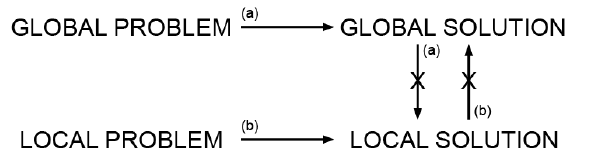
Figure 2. Arrows indicate the typical paths used to reach solutions (a) and (b). Crosses indicate where the difficulties can be found. For example: to reach solutions (b) designers start from local problems and reach unique and “appropriate” solutions. Difficulties can be found in the up-scaling process (from local to global) of these